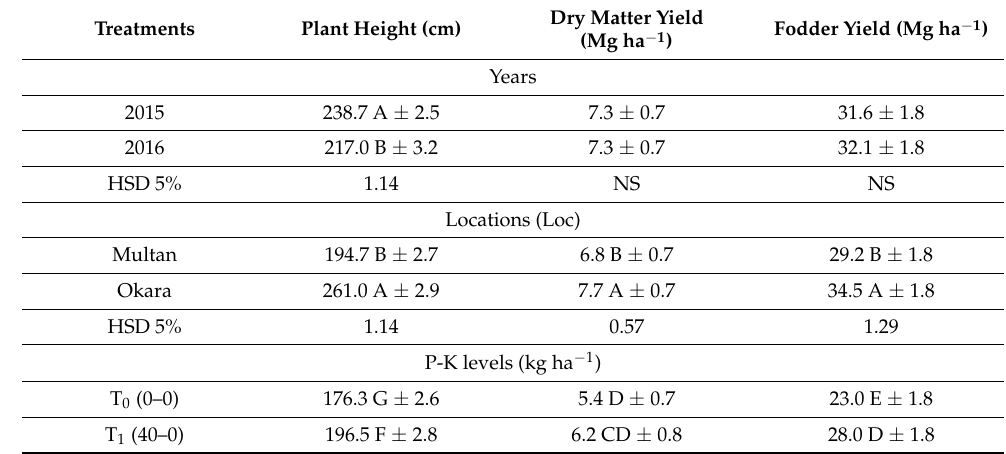
Table 3. Influence of P-K levels on sorghum growth, yield and yield traits during both years and